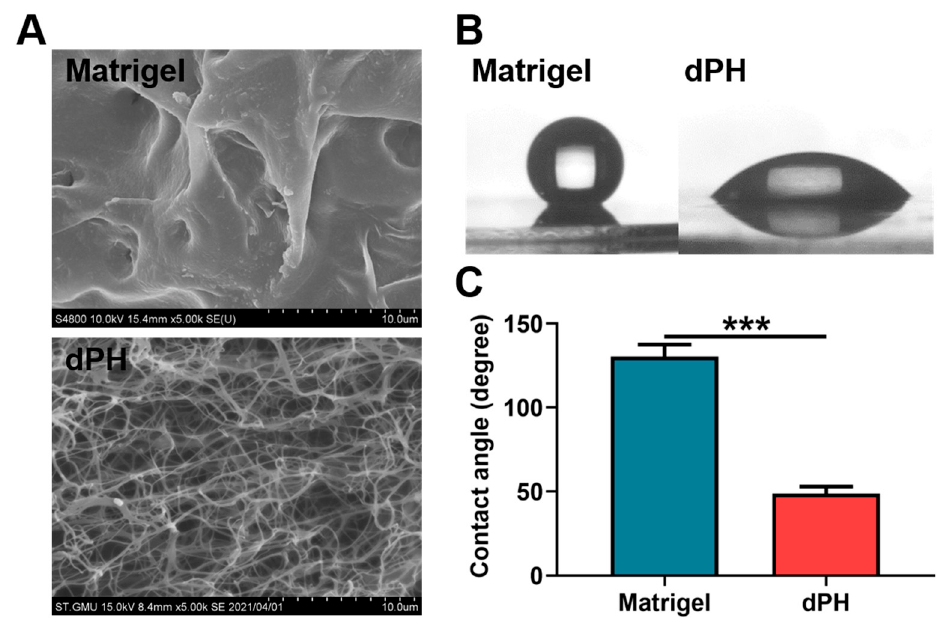
Figure 3. Morphological observations and hydrophilic study of Matrigel and dPH. ( A ) Representative images of Matrigel and dPH observed using SEM. ( B ) Representative optical images of hydrophilic study. ( C ) Quantitative analysis of WCA. *** p < 0.001.